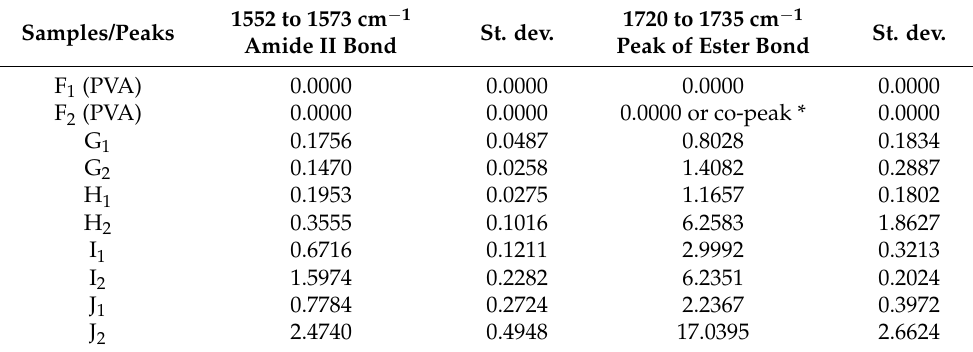
Table 6. The fitted IR peaks corresponding to amide II and ester bonds. 1552 to 1573 cm − 1 Samples/Peaks St. Amide II Bond